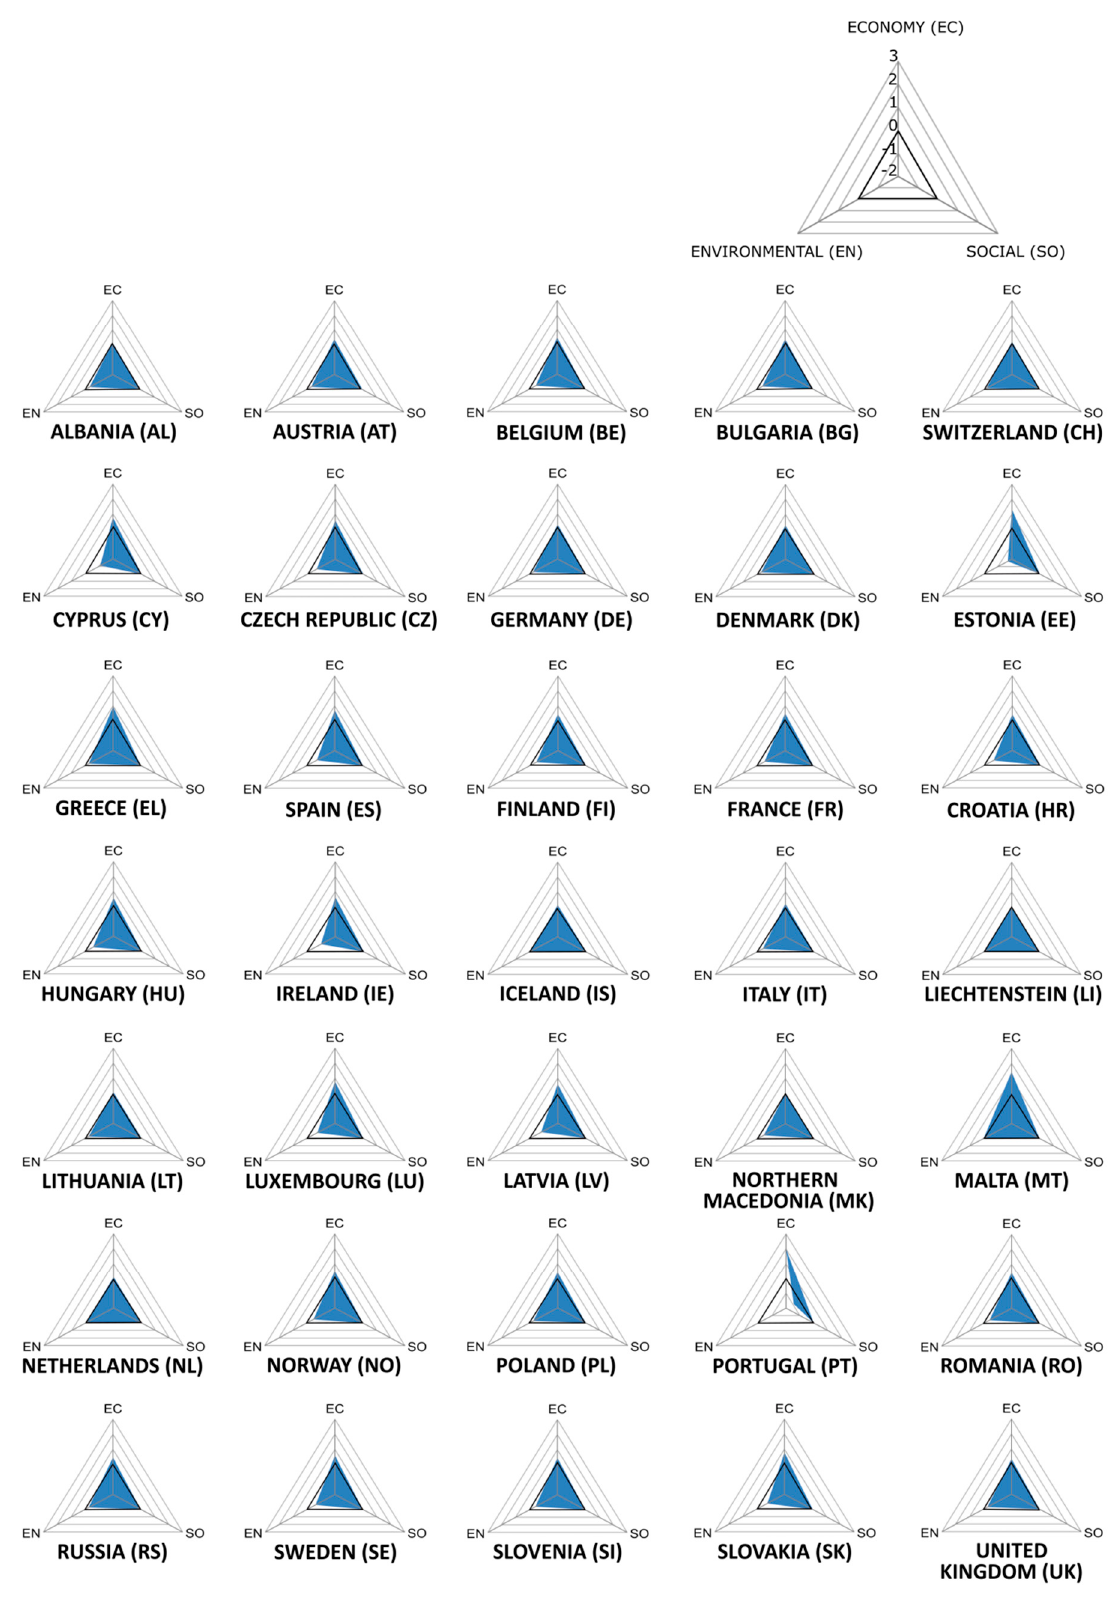
Figure A7. Sustainability assessment of local change directions in country - DEGURBA level 3